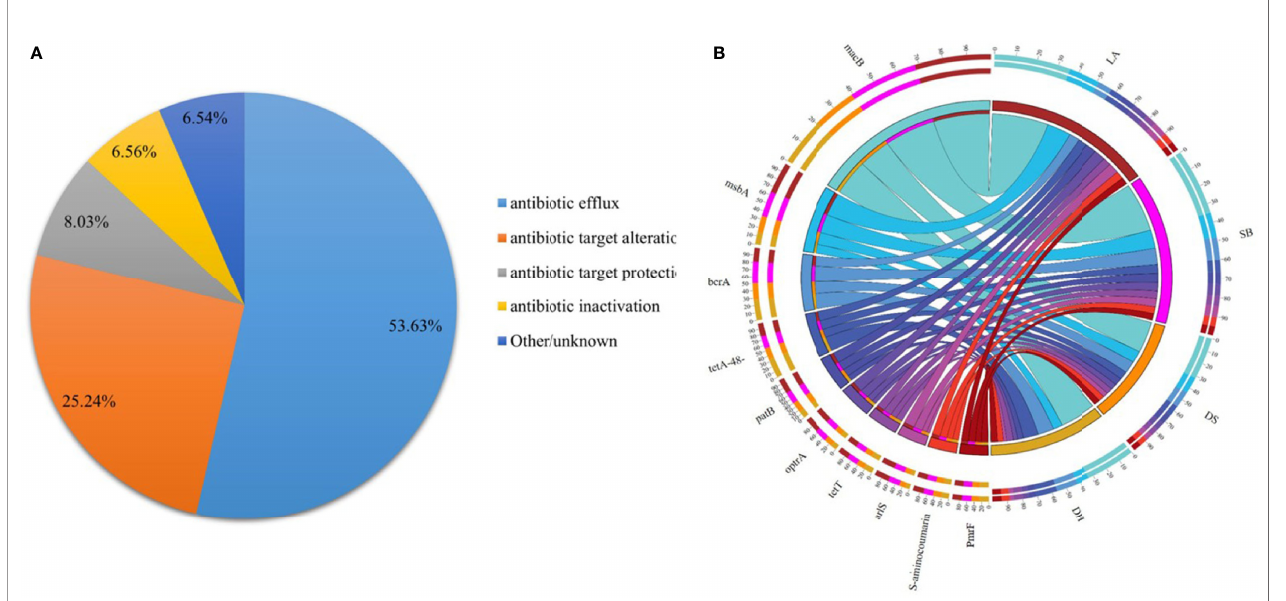
FIGURE 5 | Resistance Mechanism and antibiotic resistance ontologies of antibiotic resistance genes. (A) Composition and proportion of resistance mechanisms in four pig breeds. (B) Functional distribution of top 10 most abundant antibiotic resistance ontologies in each